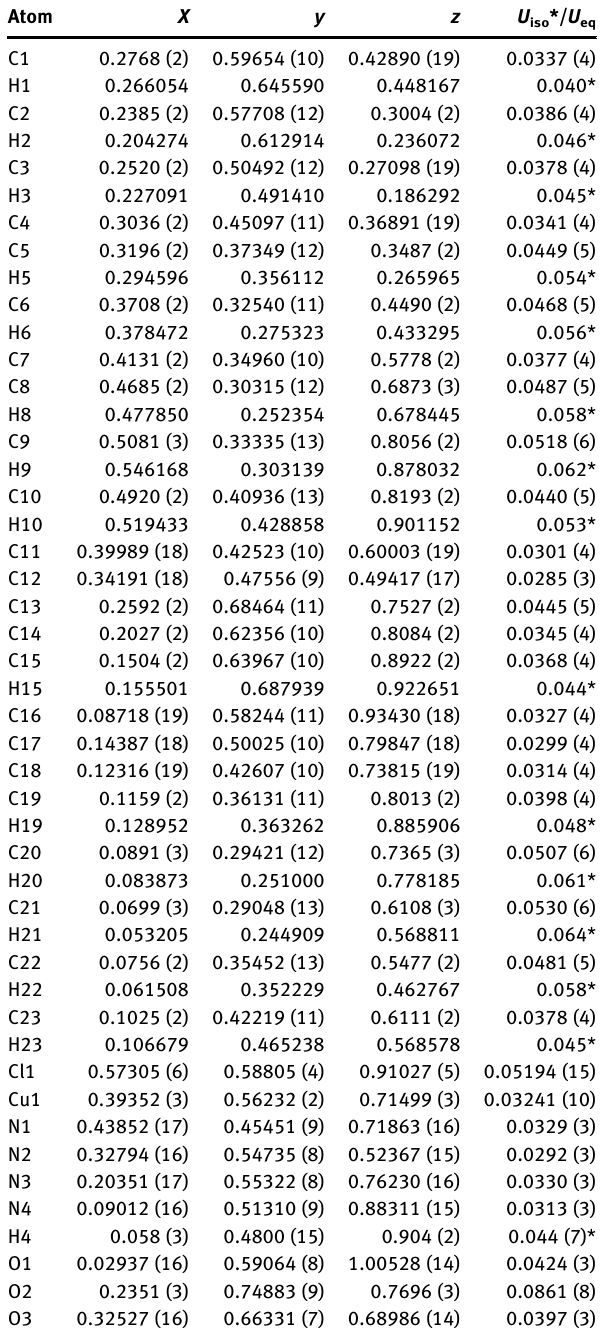
Table  : Fractional atomic coordinates and isotropic or equivalent isotropic displacement parameters (Å 